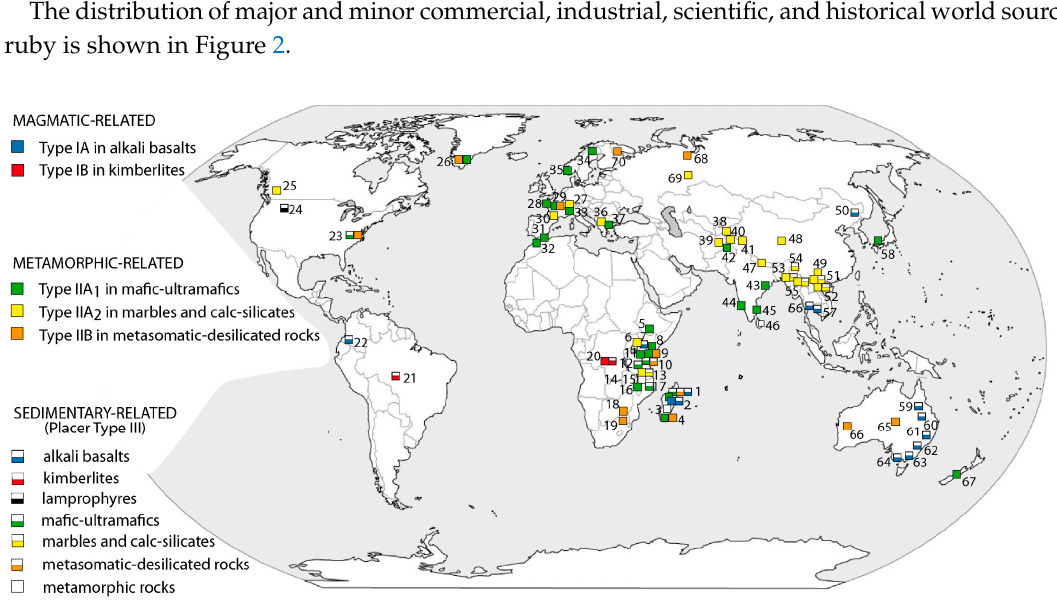
Figure 2. Main major and minor world sources of ruby plotted according to their geological types. Figure